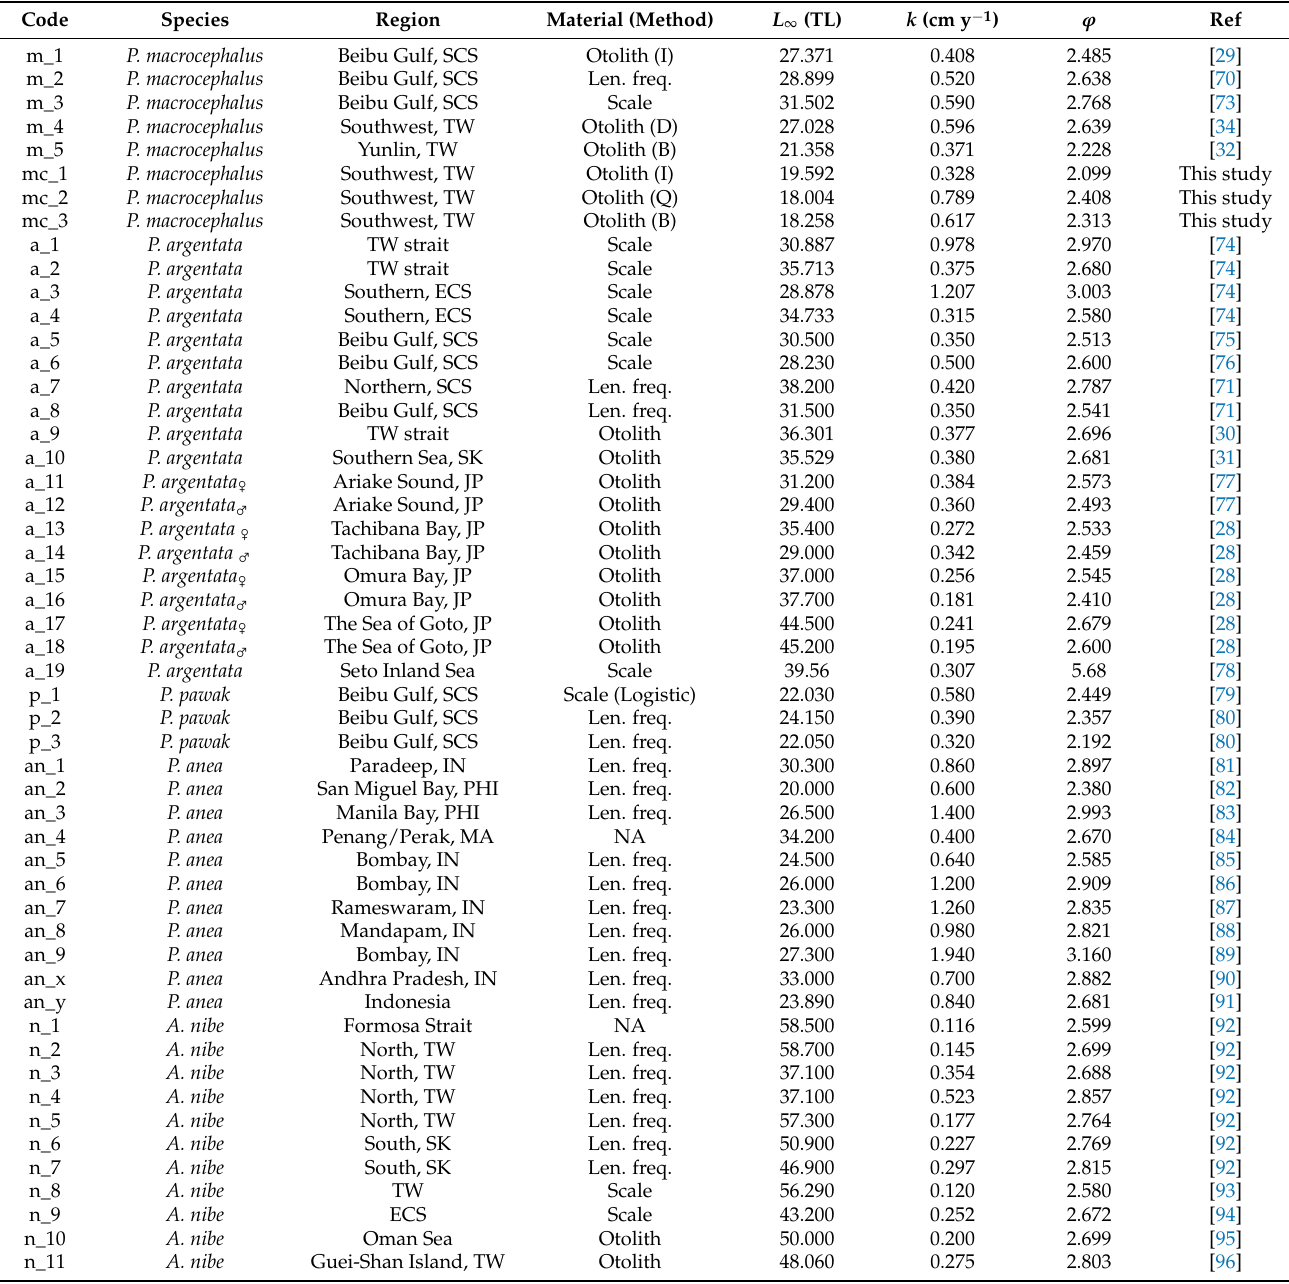
Table 1. Global estimates of growth parameters of Pennahia and Atrobucca spp. from the literature. Lengths are in the unit of cm and k in year − 1 . Refer to Table S1 for detailed